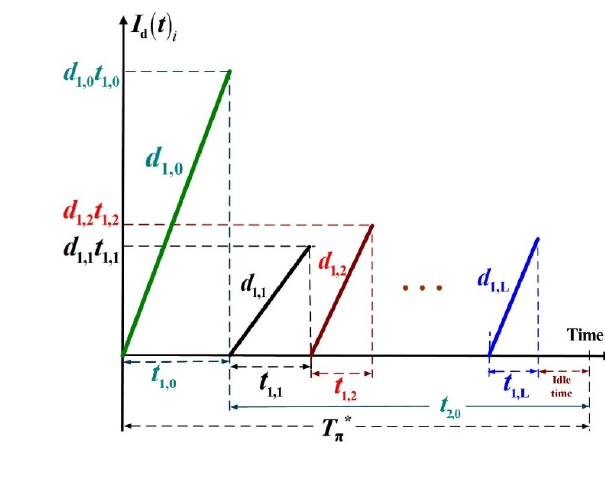
Fig. 2. The proposed model’s scrap status at time